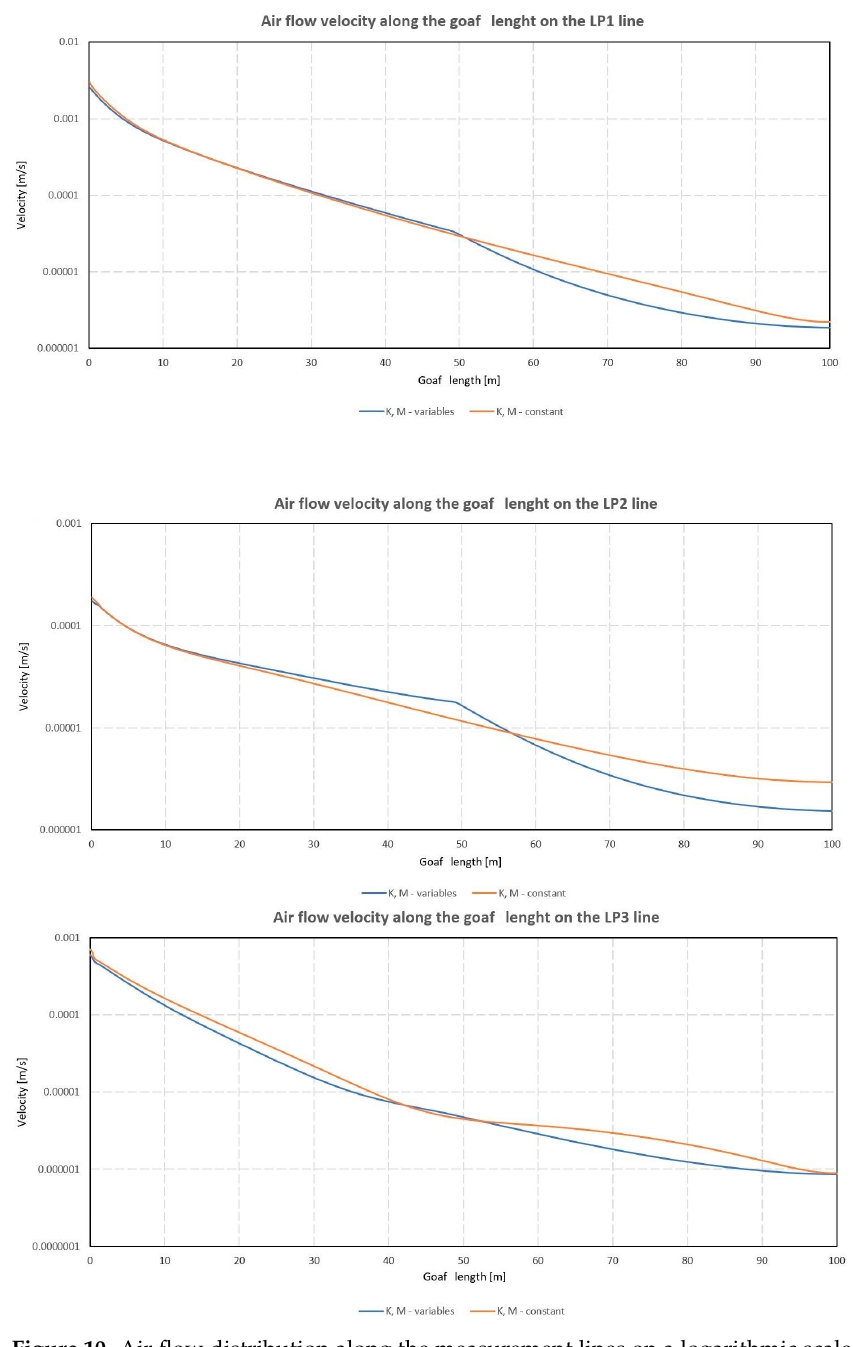
Figure 10. Air flow distribution along the measurement lines on a logarithmic scale for the model with constant and carriable values of porosity and permeability in goafs.